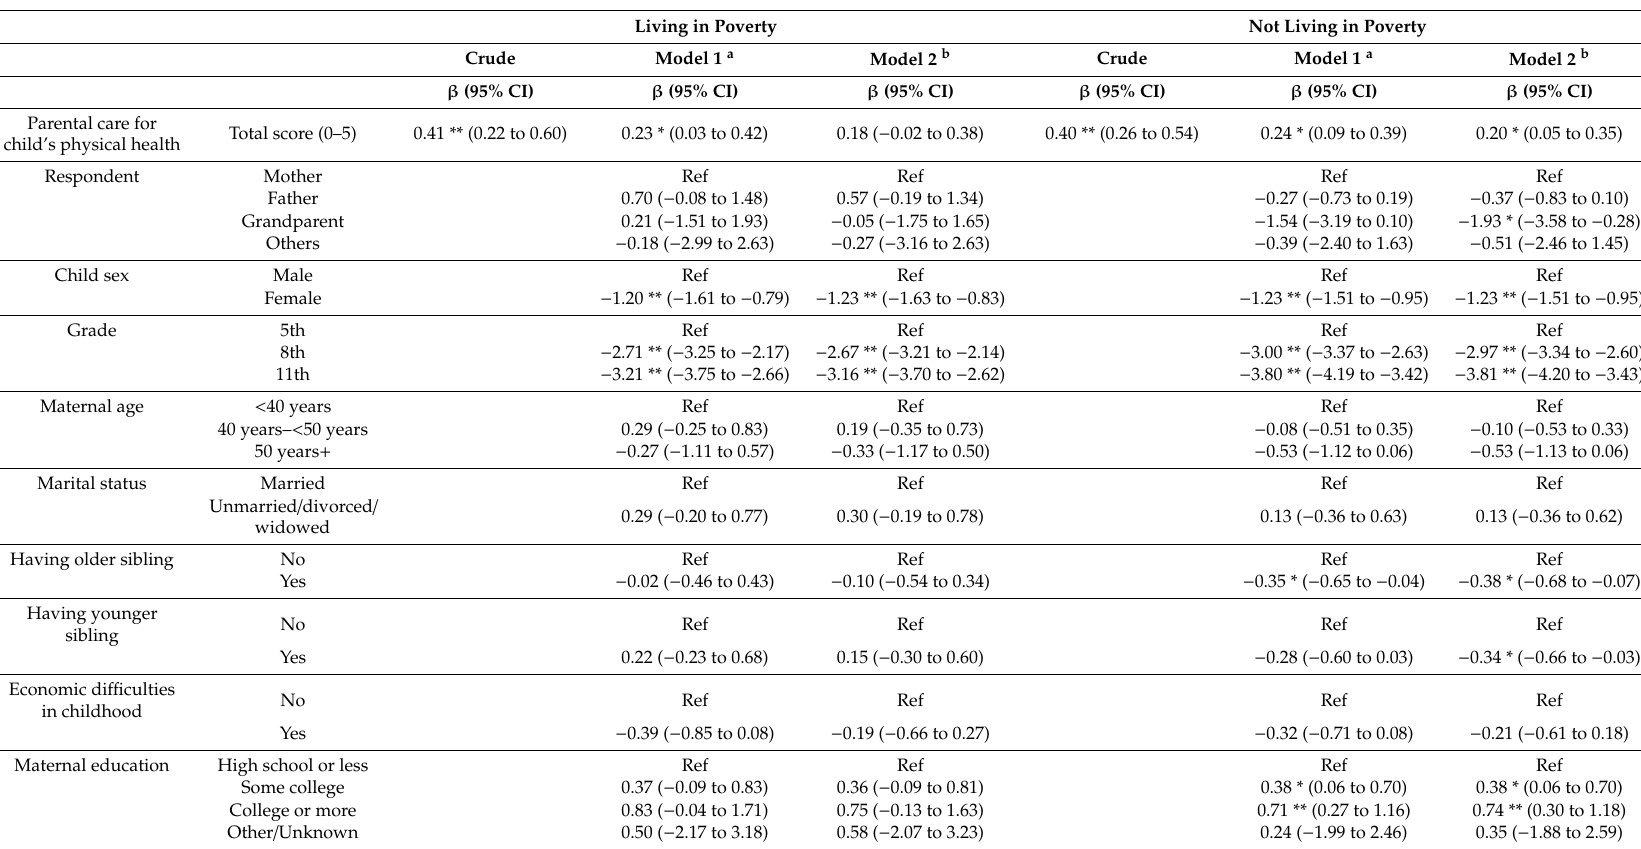
Table 5. The association between the amount of parental care for a child’s physical health and self-esteem among adolescents living in poverty ( n = 3696) and not living in poverty ( n =